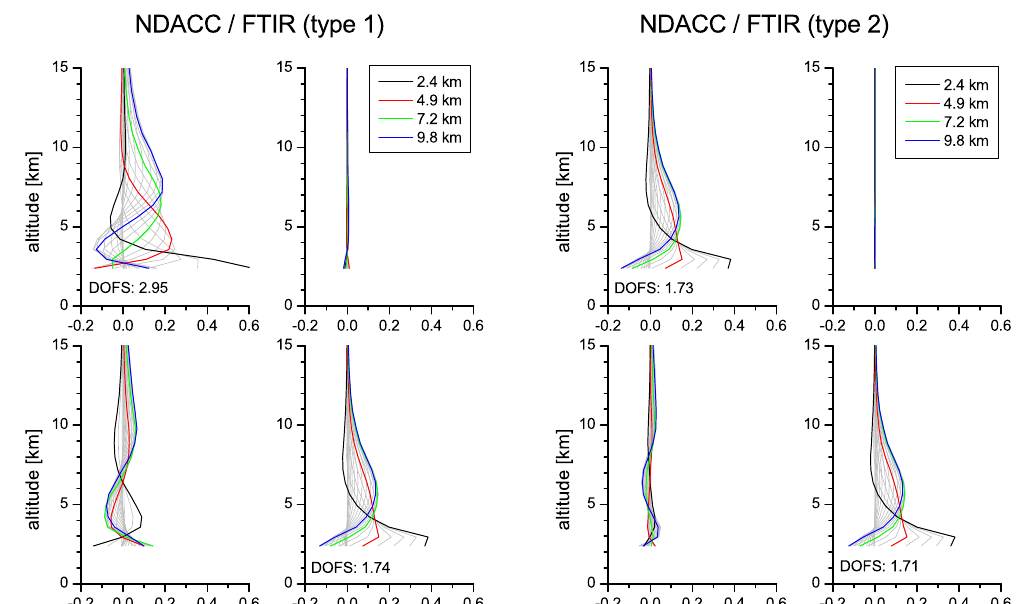
Figure 3. Typical row kernels for the { H 2 O, δ D } -proxy states as retrieved from Izaña’s ground-based NDACC/FTIR spectra. Left panel of graphs: product type 1 kernels; Right panel of graphs: product type 2 kernels. The upper graphs of each panel display how the retrieved H 2 O is affected by actual H 2 O variations (left graph) and by actual δ D variations (right graph). The lower graphs of each panel display the same for the retrieved δ D. For more details on the proxy state kernels see Schneider et al.